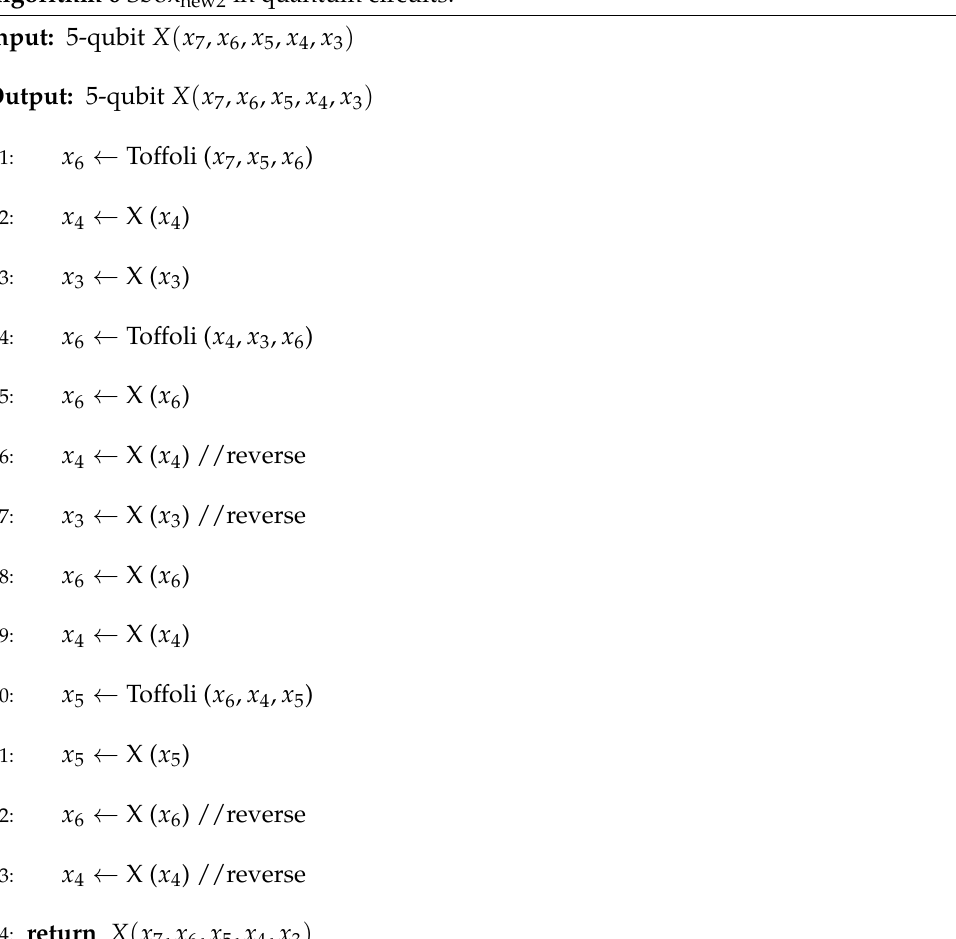
Algorithm 6 Sbox new2 in quantum